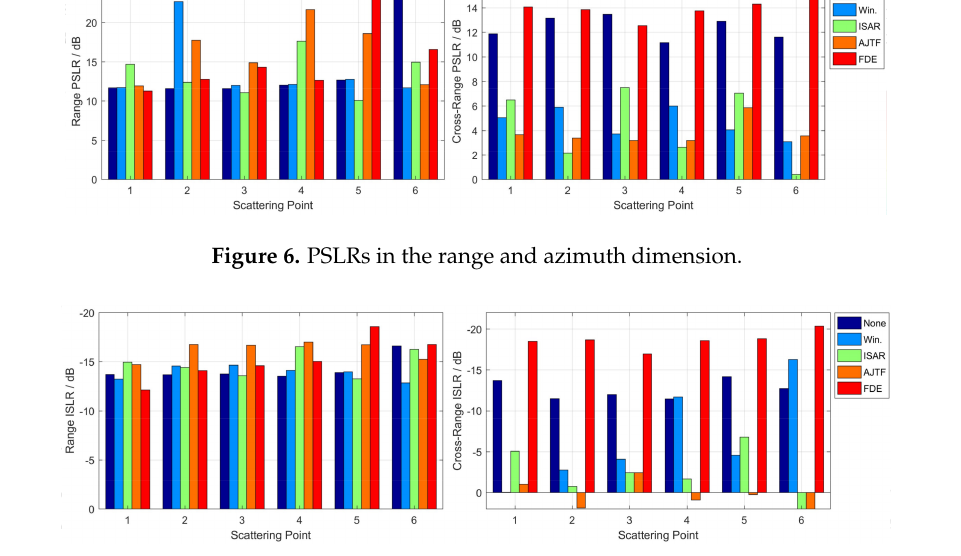
Figure 7. ISLRs in the range and azimuth dimensions.